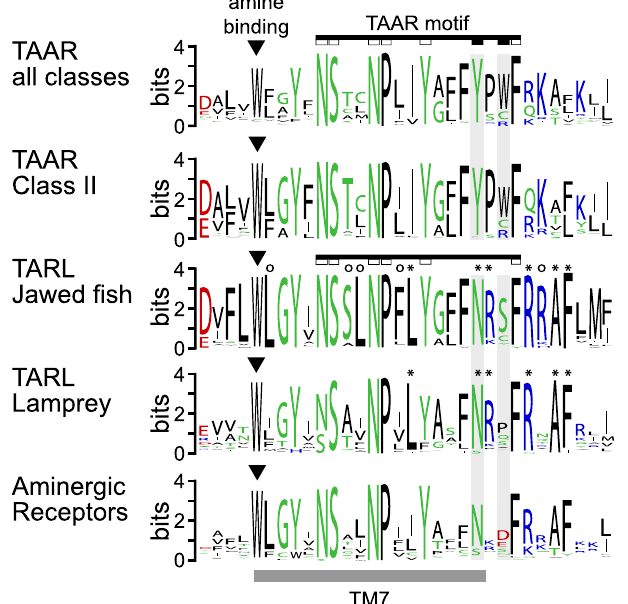
Figure 2. Absence of the TAAR-specific fingerprint motif in taar -like genes. The characteristic fingerprint motif (black bar) of taar genes 16 and the respective homologous sequence regions in taar- like genes (TARL) and aminergic receptors (AmR) are vertically aligned. Grey bar, transmembrane region 7. Note that the positions of the motif denoted by empty rectangles are highly conserved in all gene groups shown. In stark contrast, the two TAAR-specific positions of the motif (Y and W, filled rectangles) are differently conserved-N instead of Y ( tarl genes from jawed and jawless fish, and aminergic receptors)-S instead of W ( tarl genes from jawed fish)—or not conserved in non- taar genes. Asterisks, additional amino acids are conserved in all tarl genes; empty circles, amino acids only conserved in tarl genes from jawed